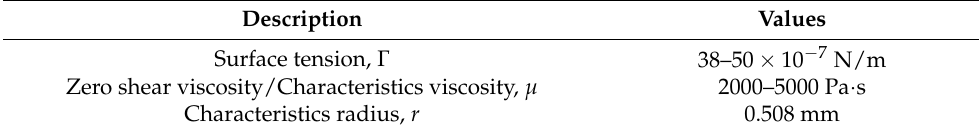
Table 1. Parameters Γ , µ , r to estimate t s .